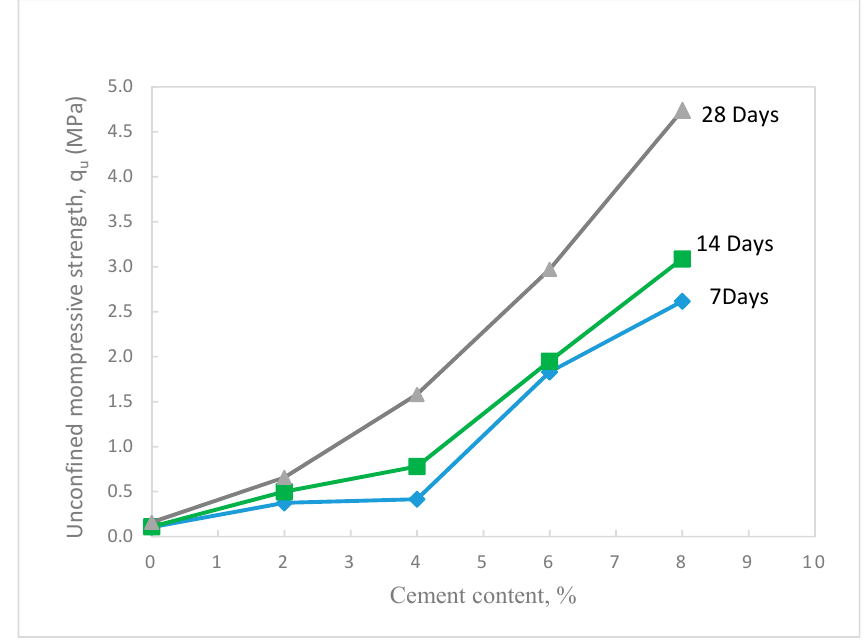
Figure 9. Variation of unconfined compressive strength of the treated waste sand with cement content for different curing times. Materials 2019 , 12 , x FOR PEER REVIEW